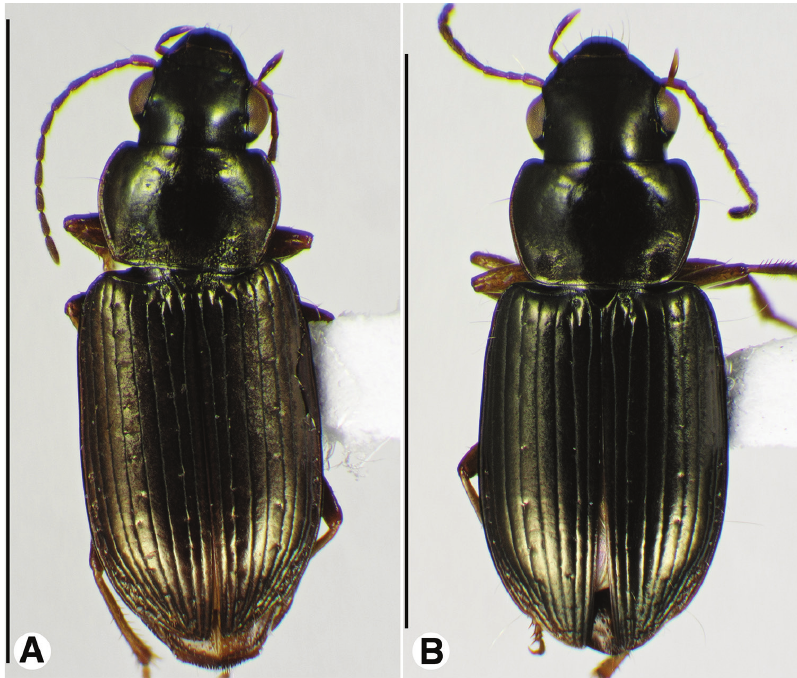
Figure 54. Habitus digital images of Selenophorus parumpunctatus species group, dorsal aspect. A S. obtu- soides sp. n. B S. parumpunctatus Dejean. Scale bars 5